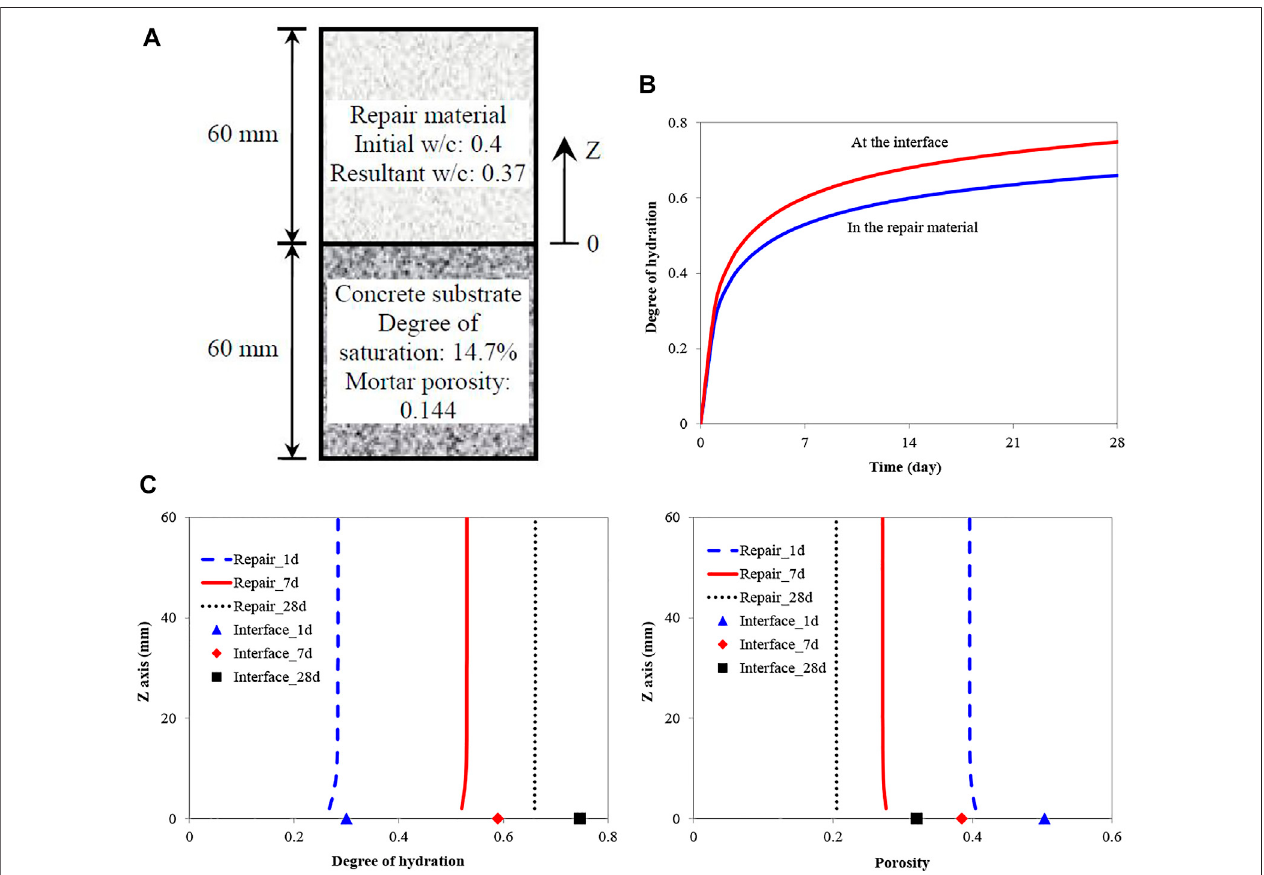
FIGURE11| Degreeofhydrationinthebulkrepairmaterialandattheinterface. (A) Inthe fi rst28 daysobtainedfromthesimulation, (B) thedegreeofhydrationat1, 7 and 28 days, (C) porosity at 1, 7 and 28